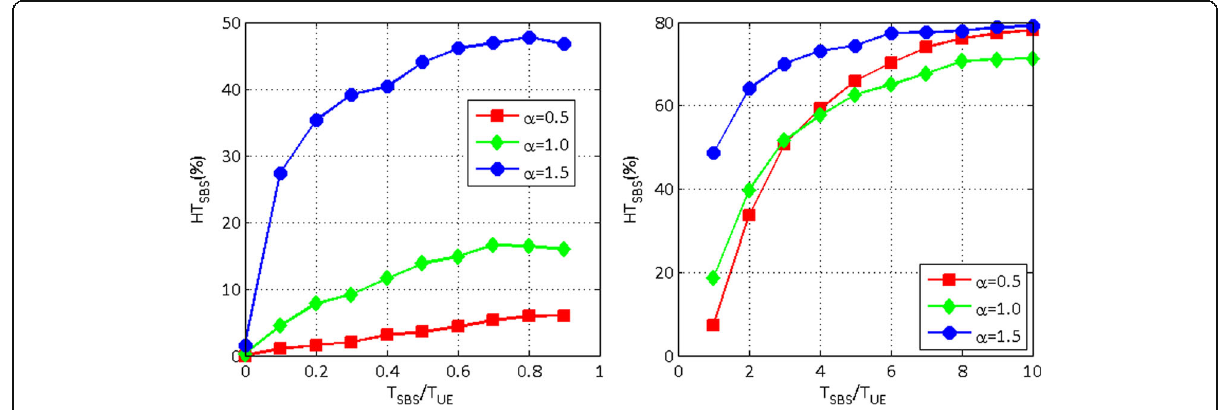
(cid:3) Fig. 16 Impact of T SBS T UE to hit rate in the SBS level in ER model (